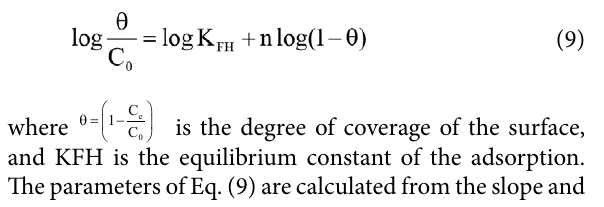
Figure 7. Dependence of distribution coefficient on the tempera- ture.